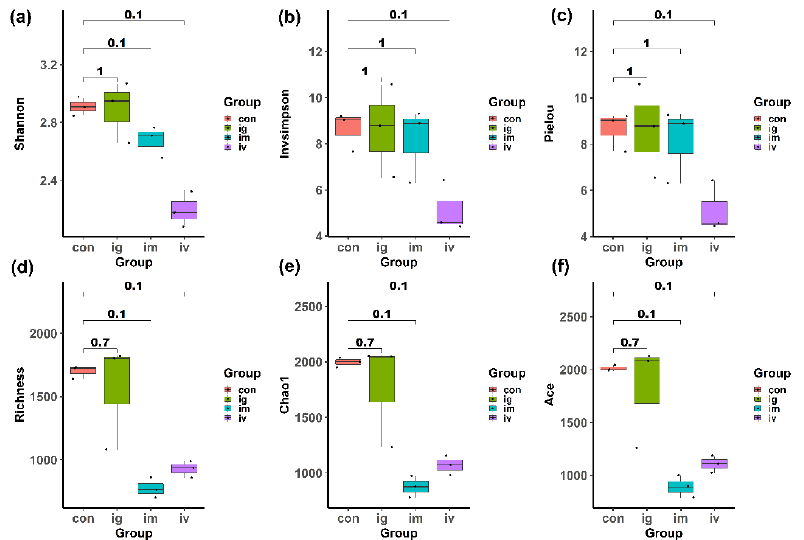
Figure 5. MPDA caused no significant differences in the intestinal bacterial community of Alpha diversity. ( a ) Shannon index; ( b ) Invsimpson index; ( c ) Pielou index; ( d ) richness; ( e ) Chao1 index; ( f ) Ace index. Wilcoxon rank sum test was used to compare control and treatment groups, and the p -value threshold was set at 0.05 for statistical significance.